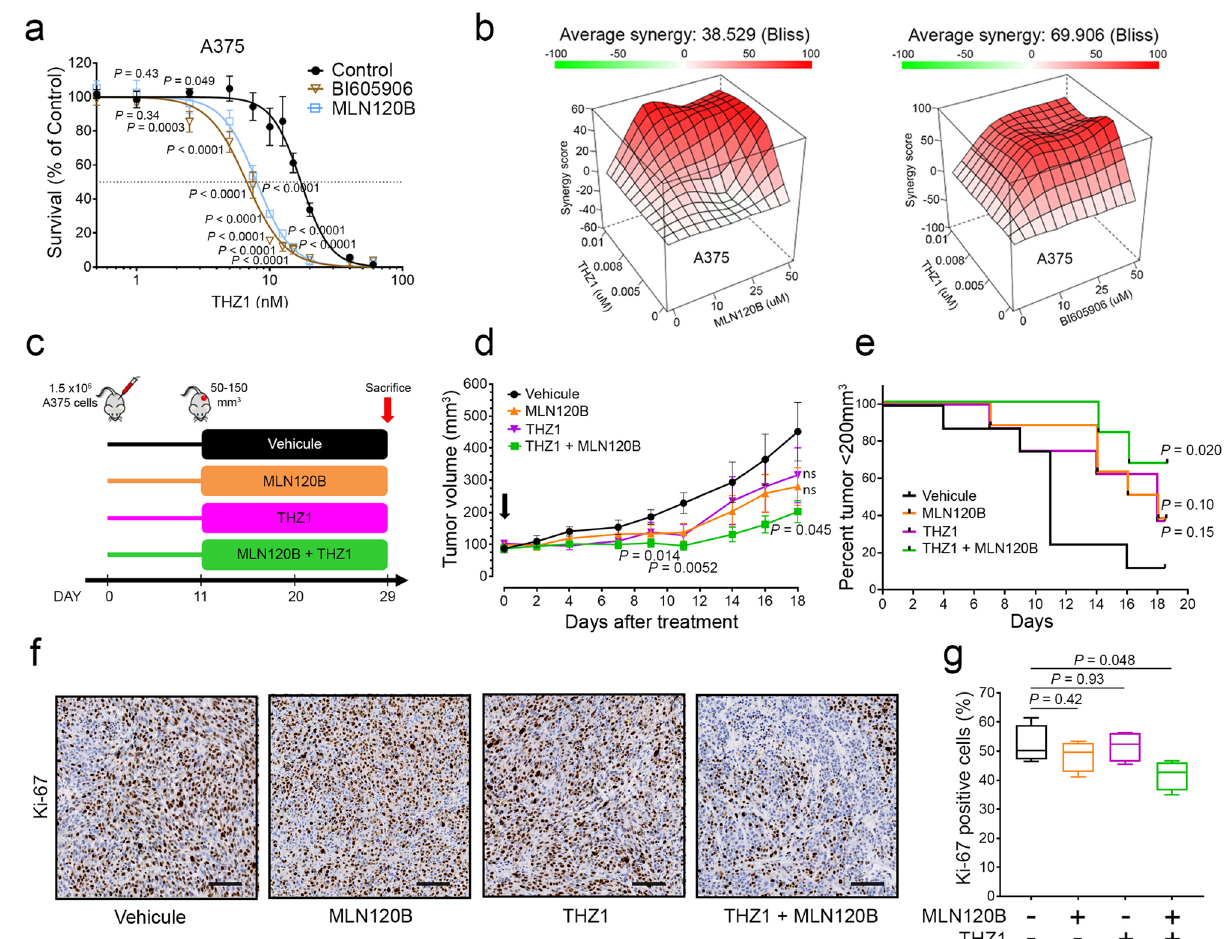
Fig. 7 | CDK12 inhibition is potentiated by NF- κ B inhibition in vivo. a Proliferation assay was performed in A375 cells treated with THZ1 at indicated doses combined with BI605906 (10 µ M) and MLN120B (20 µ M) for 72h. IC 50 for THZ1 alone, in combination with BI605906 or MLN120B (17.2nM, 6.7nM and 6.3nMrespectively). b ExcessoverBlisssynergyplotsforserialdilutionsofTHZ1in combination with BI605906 or MLN120B in A375 cells. Bliss scores >10 indicate drug synergy. c In vivo protocol used to evaluate the role CDK12 and IKKB inhibi- tion in BRAF-mutated melanoma cells. d Tumor volume measurements of an A375 xenograft mouse model treated with vehicle, 10mg/kg THZ1 IP BID, 50mg/ MLN120BPOBID,orthecombinationofTHZ1+MLN120B.Treatmentwasstopped